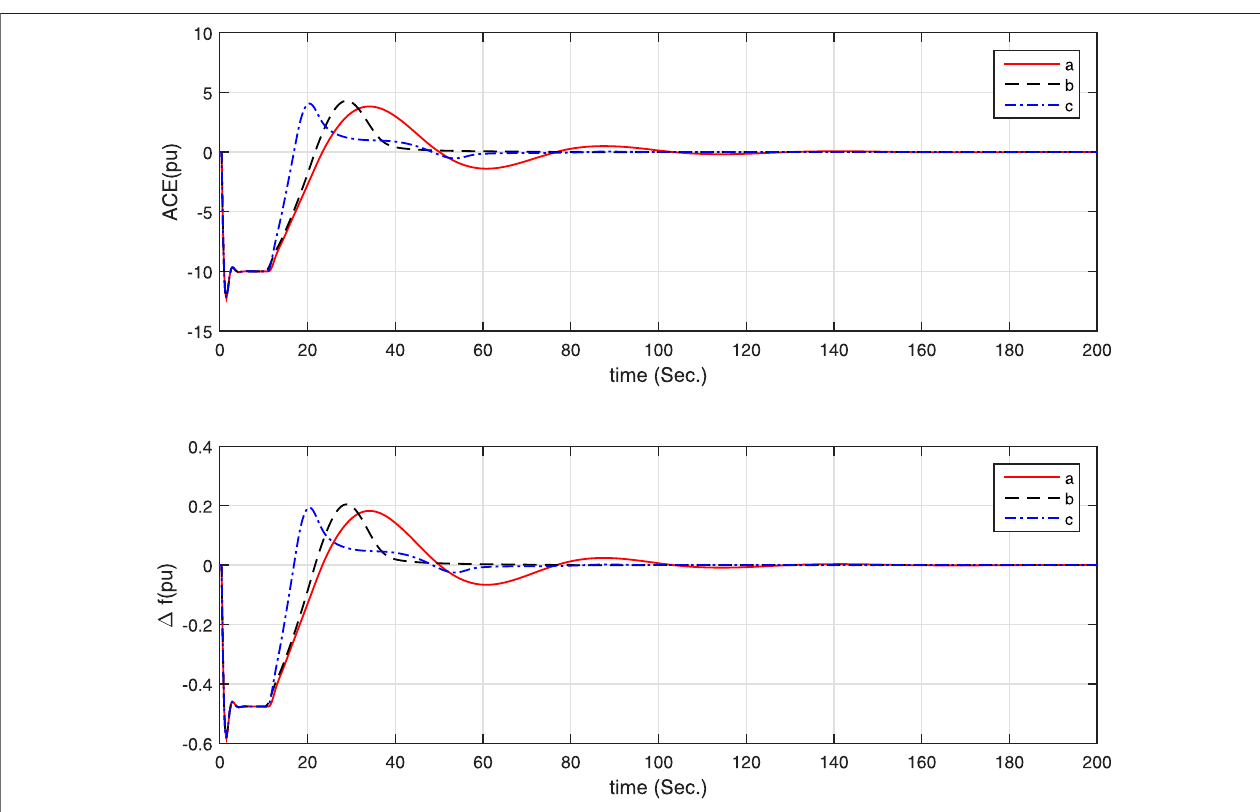
FIGURE 5 | Frequency deviation and control error responses of one-area LFC scheme under c (cid:2) 0.4.